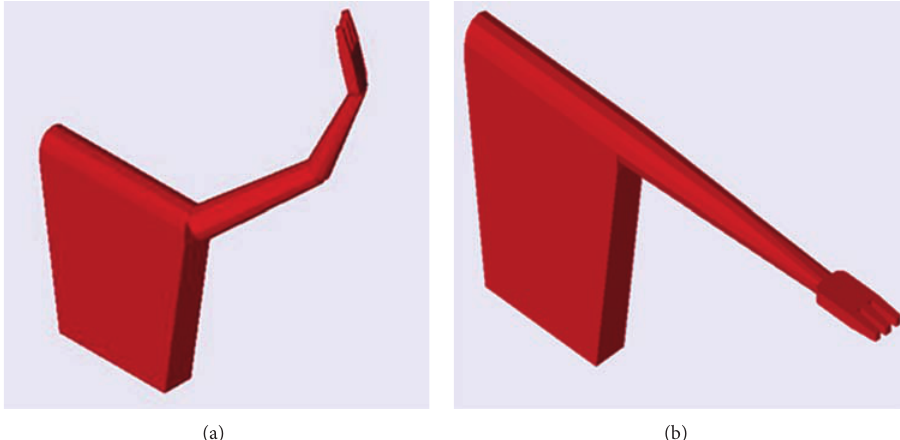
Figure 13: (a) Simulink model of human hand, (b) human hand position at zero position.